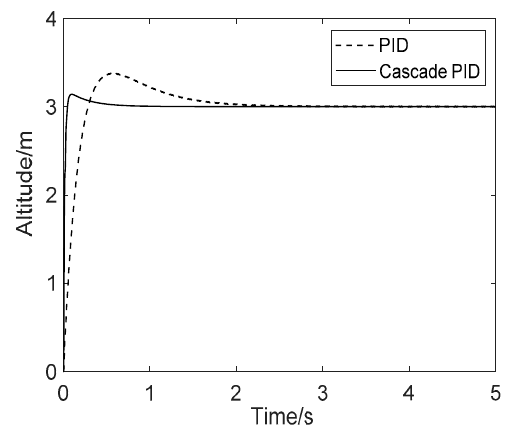
Figure 9. Dynamic response curve of the single-stage/cascade PID controller.